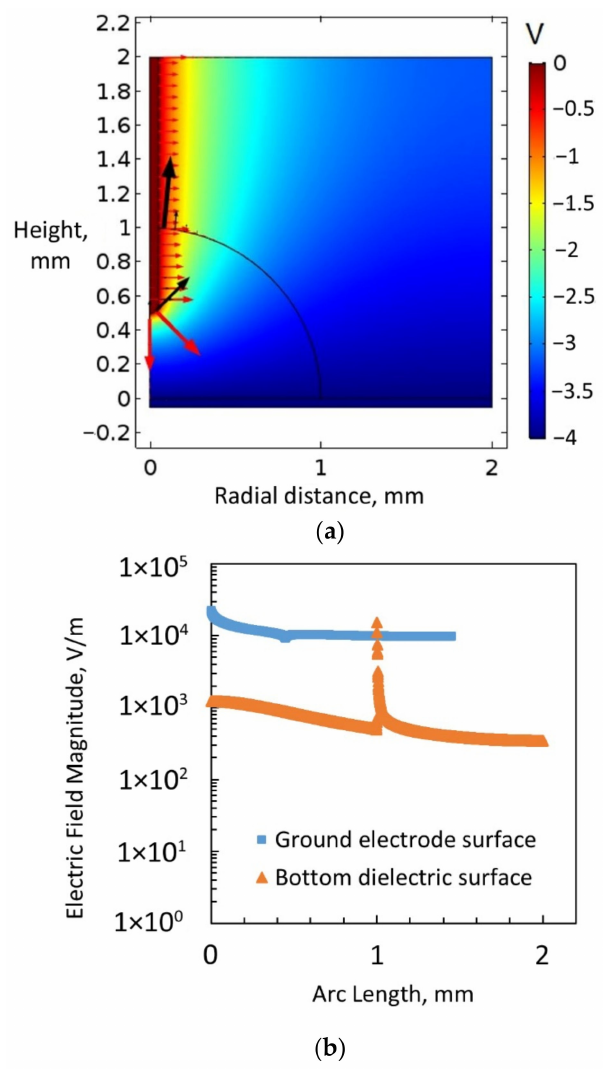
Figure 9. ( a ) Electric field simulation considering water to be a leaky dielectric, with a bare ground electrode exposed to a sessile water drop and 4 V applied to the bottom electrode covered with a dielectric. ( b ) The electric field magnitude on the ground electrode surface and the bottom dielectric surface, considering water to be a leaky dielectric (4 V applied to the bottom